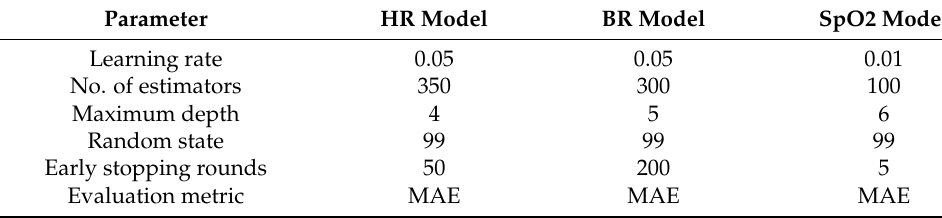
Table 7. Design parameters of the best-performing XGBoost regression